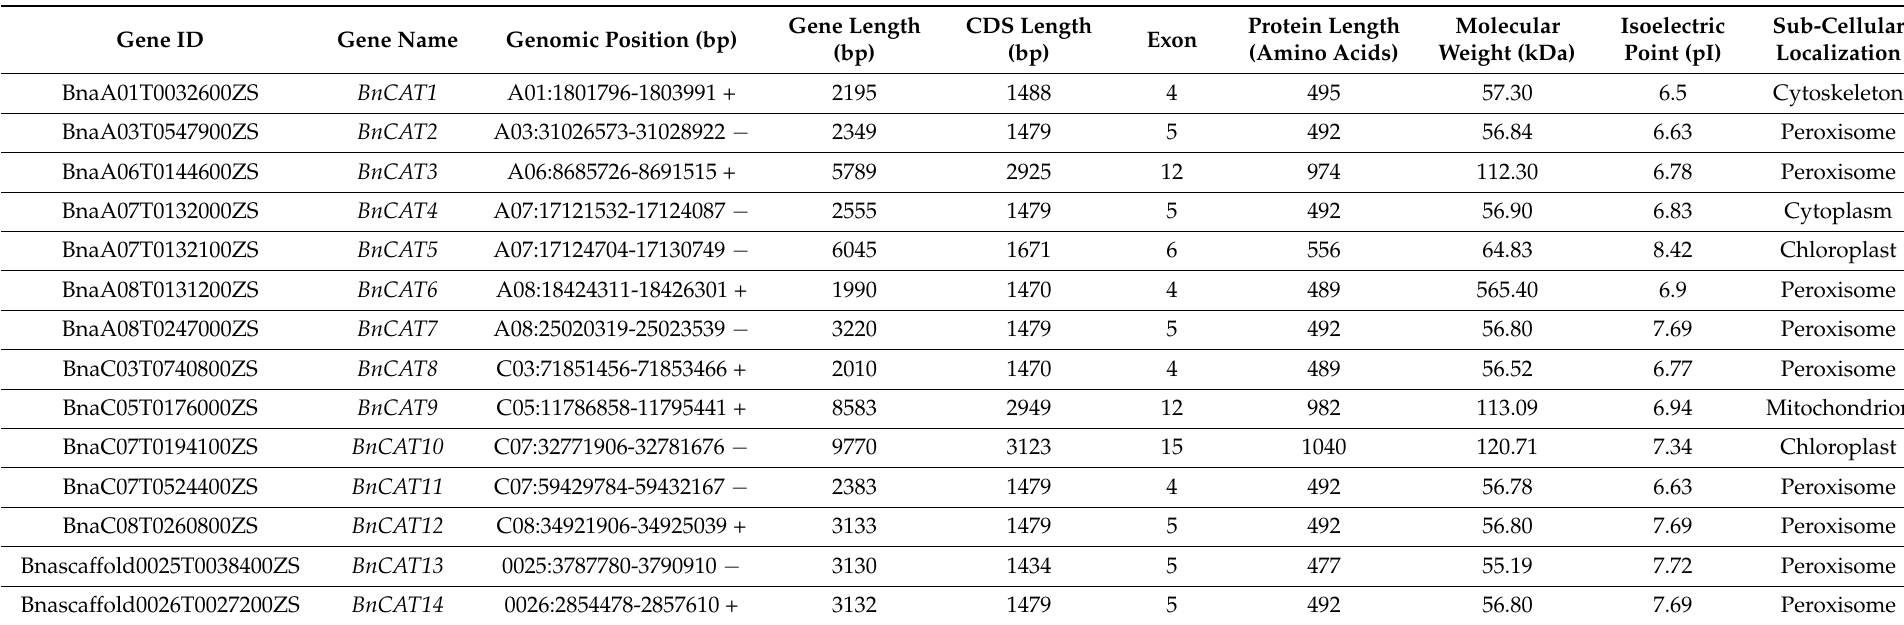
Table 1. Information of the 14 BnCAT genes identified in